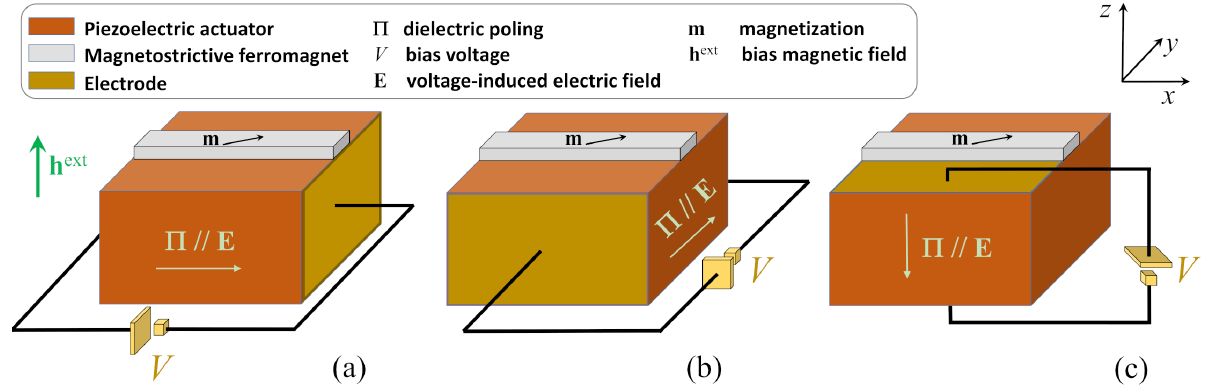
Figure 1. Layout of the three investigated configurations of the hybrid PZ/MS device where the dielectric poling and the voltage-induced electric field are collinear and aligned to the: ( a ) e x axis, ( b ) e y axis or ( c ) e z